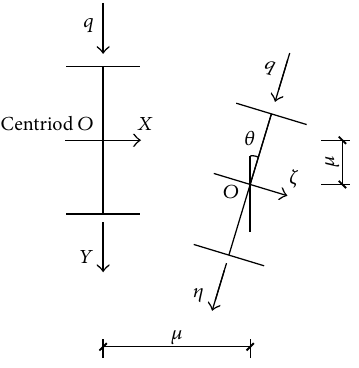
Figure 1: LTB of H-shaped steel